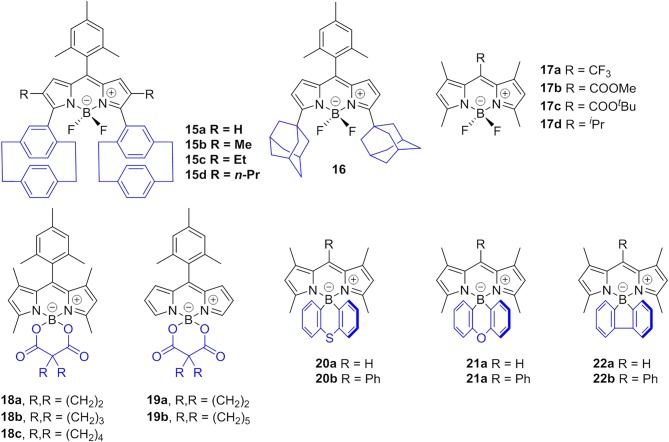
Chemical structures of compounds 15–22.